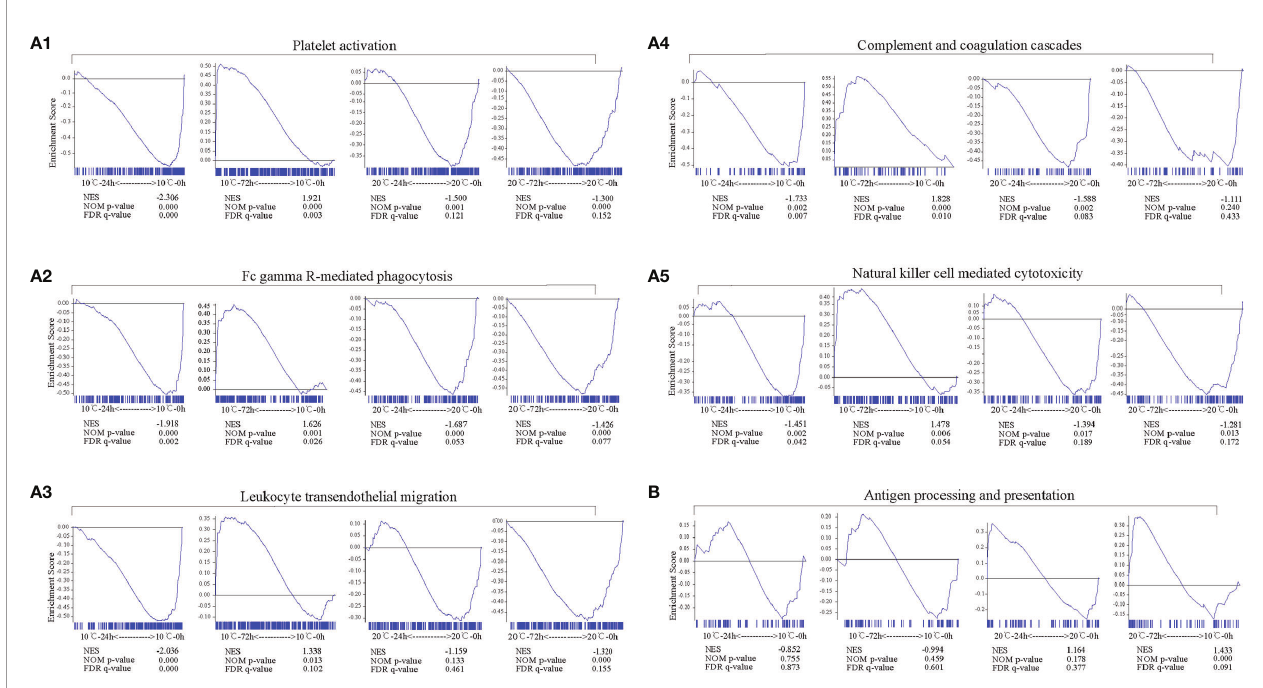
FIGURE 5 | Longitudinal changes of immune-related pathways in mIgM + B lymphocytes of infected fl ounder at 10°C and 20°C. (A1-A5, B) The immune-related pathways including Platelet activation (A1) , Fc g R-mediated phagocytosis (A2) , Leukocyte transendothelial migration (A3) , Complement and coagulation cascades (A4) , Natural killer cell mediated cytotoxicity (A5) , and Antigen processing and presentation (B) enriched in samples. GSEA was used to analyze the signaling pathways enrichment in different groups. Normalized enrichment score (NES) indicated the analysis results across gene sets. False discovery rate (FDR) presented if a set was signi fi cantly enriched. ES, enrichment